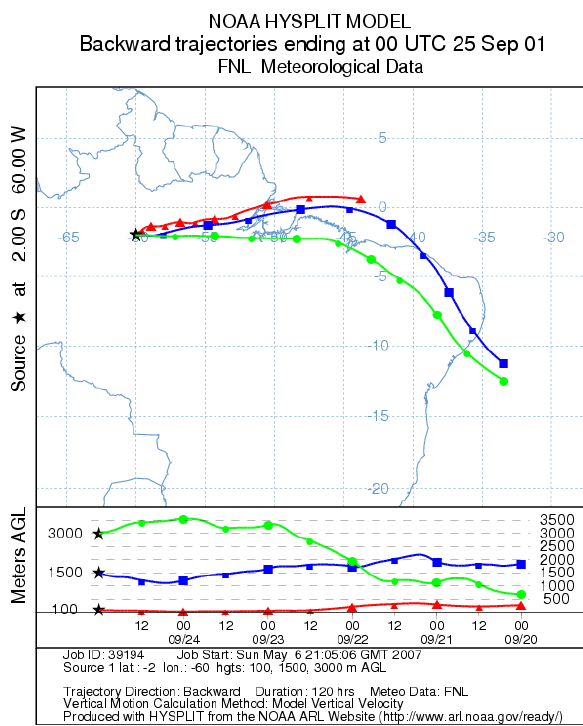
Fig. 8. Hysplit backward trajectories of air masses reaching Bal- bina at 25 September 2001, when hotspots where observed along the Amazonas river. The resulted wind streamlines are favorable to the transport of biomass-burning plumes to the sampling